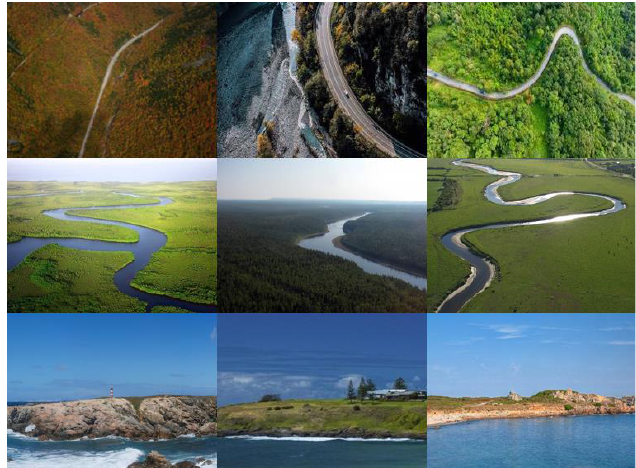
Fig. 1. Examples of regions with strong curvature to be segmented. Often such objects can divide the image in two parts (upper and lower) like the coast separates the sky from the seawater (in the last two images in the third